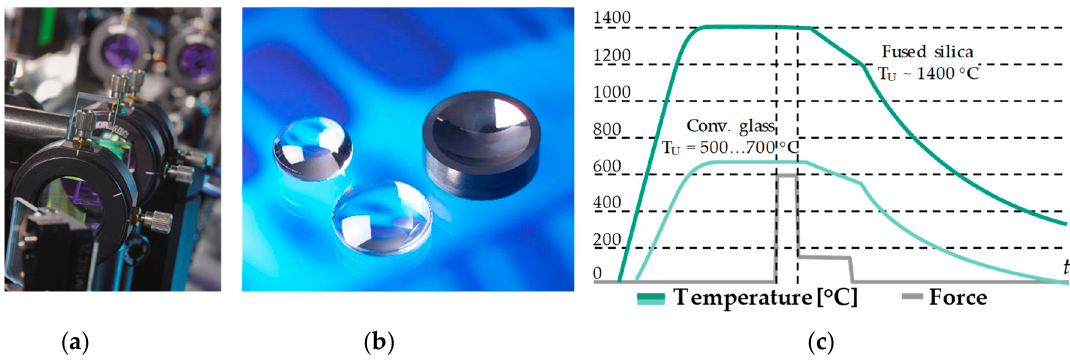
Figure 1. ( a ) Beam shaping optics in laser systems; ( b ) Aspherical Fused Silica lenses produced by PGM; ( c ) PGM process chart of Fused Silica moulding (PGM, Precision Glass Moulding).